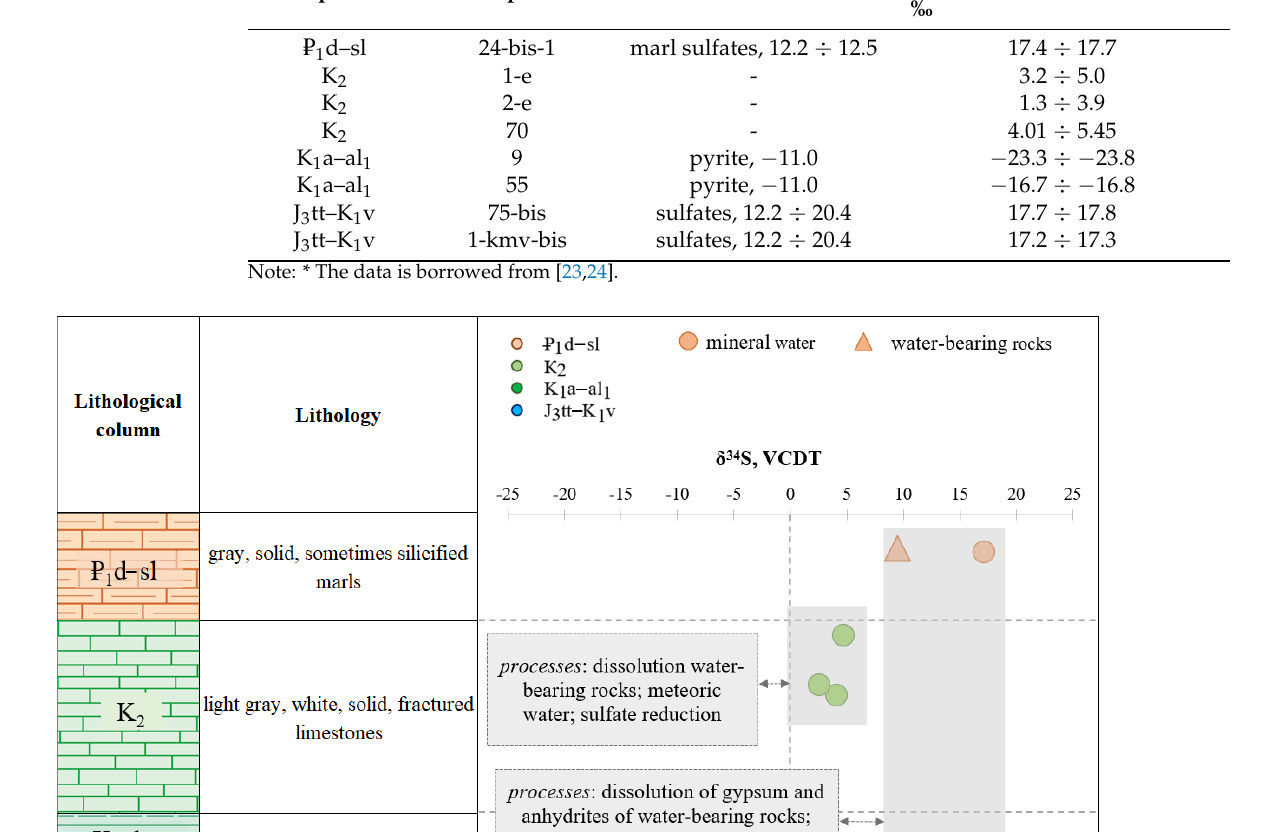
Table 1. Characteristics of the studied water samples.